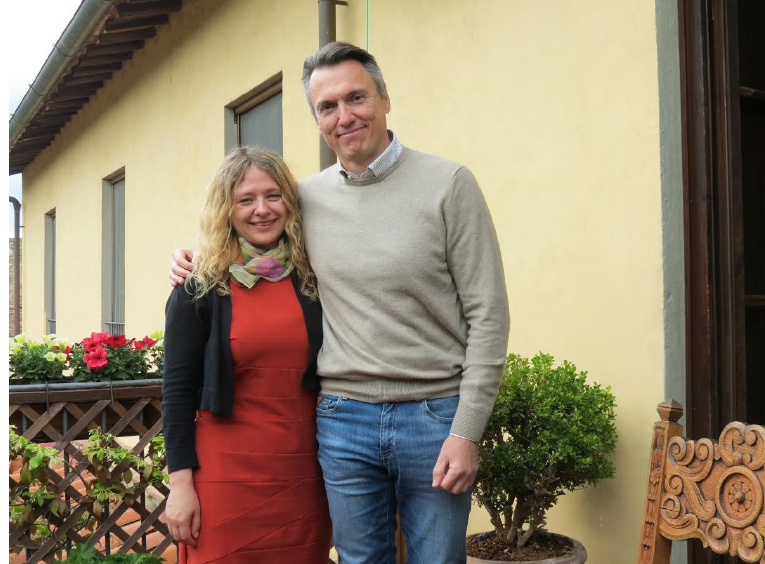
Figure 1. The Lithuanian philosopher Jolanta Saldukaitytė with Andrei Tarkovsky’s son Andrei Tarkovsky during the visit at Tarkovsky’s flat, recently museum in Florence, Italy in 23 April, 2017 (source: Jolanta Saldukaitytė’s personal